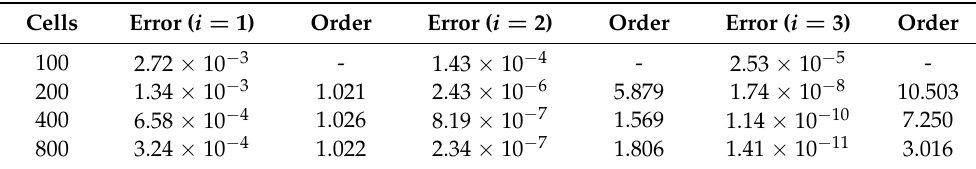
Table 6. Test 2.1. Differences in L 1 -norm with respect to the stationary solution for CWBM i , CLWBM i , i = 1,2,3. Order 1: Cells